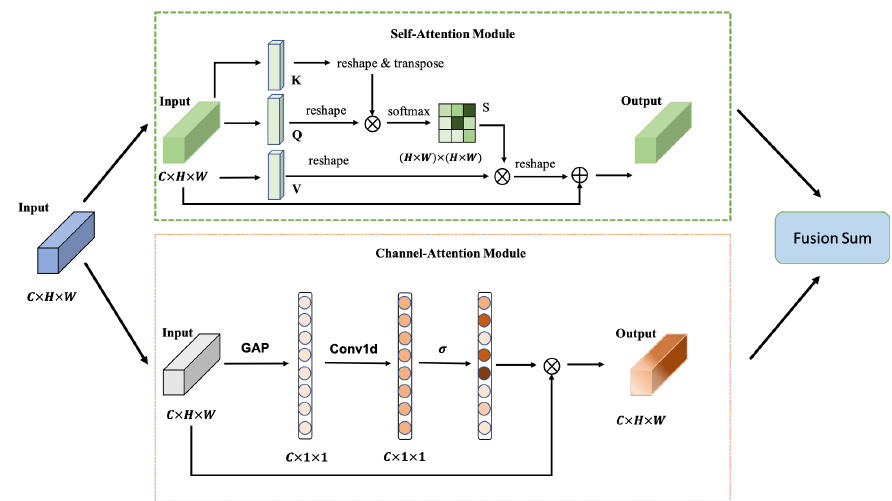
Figure 3. The structure of the attention module. The input of the attention module is the extracted features of the CNN backbone. The output of the attention module is forwarded to the